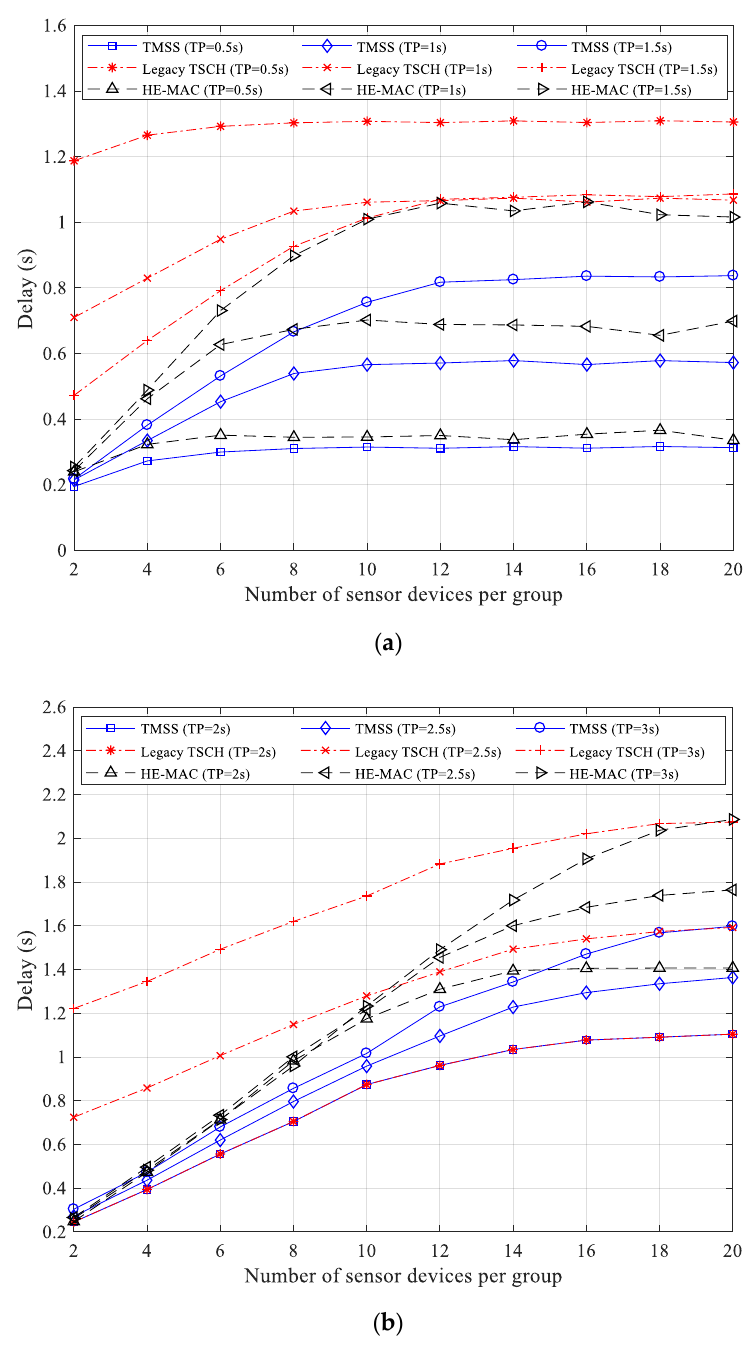
Figure 6. Delay: ( a ) short transmission period (TP) scenario; ( b ) long TP scenario.